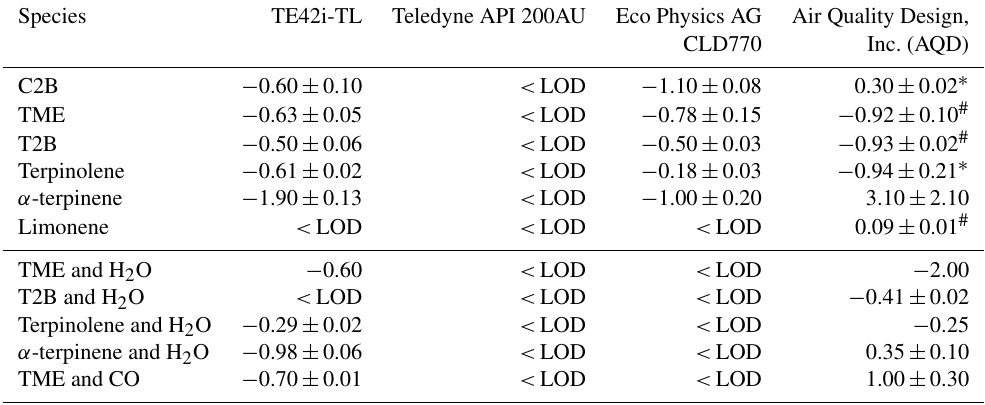
Table 3. Measured NO 2 interference (% ± 1SD of the slope) for each monitor across a range of different alkenes (LOD – limit of detection).